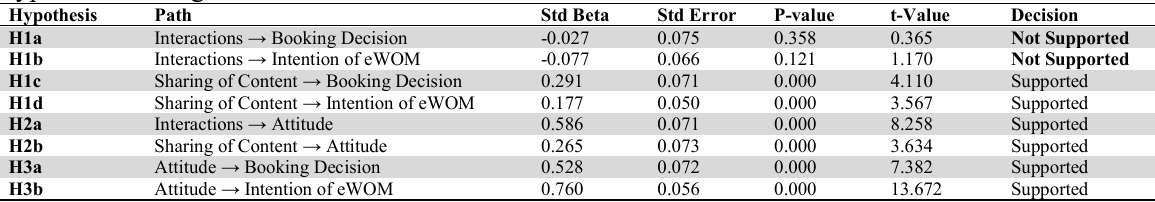
Hypothesis testing